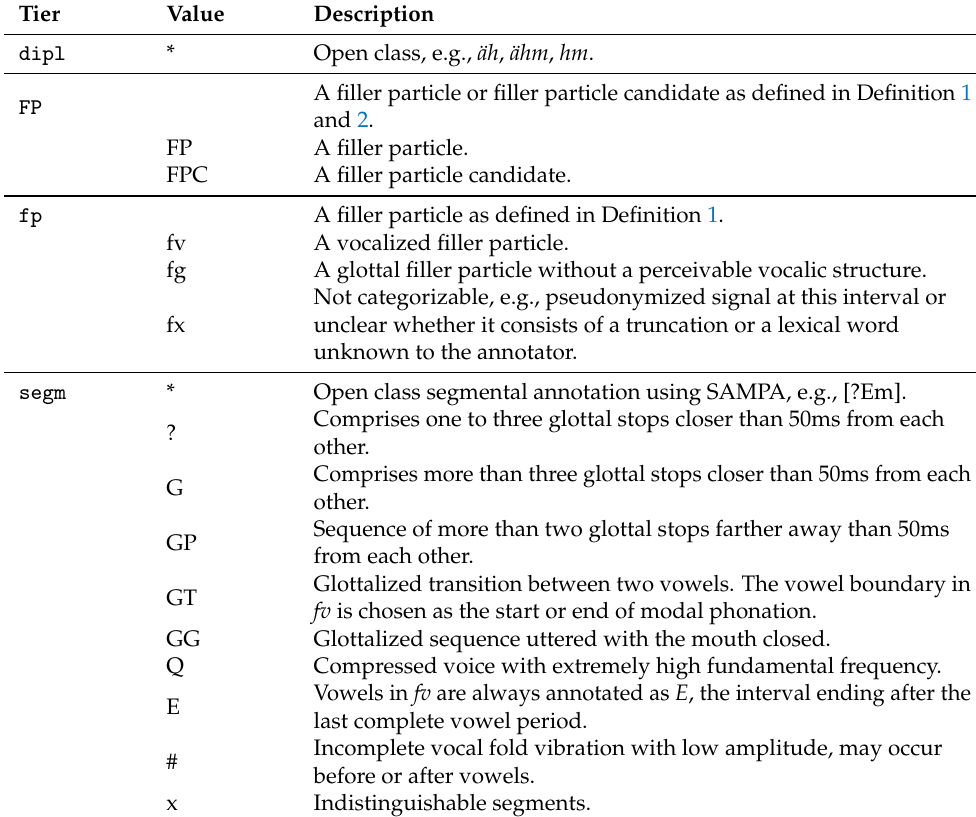
Table 2. Annotation values for the three annotation layers dipl, fp, segm in